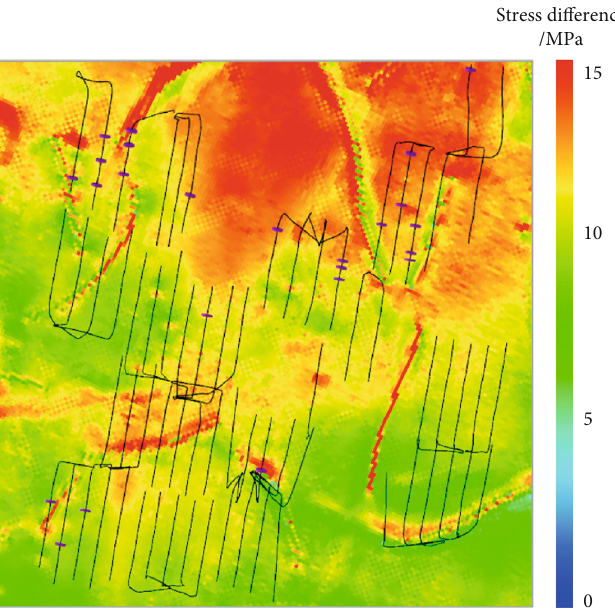
Figure 7: The distribution of horizontal stress di ff erence in the Ning209